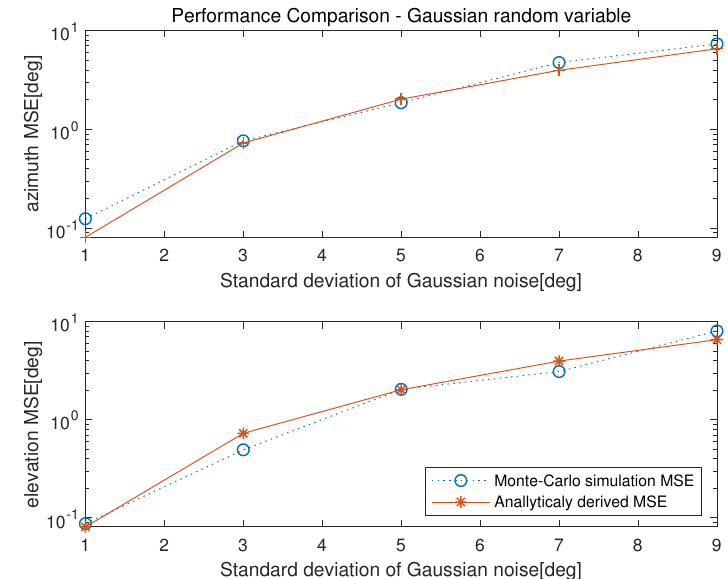
Figure 3. Performance for Gaussian − distributed phase measurement error with θ ( 0 ) = 120 ◦ and ψ ( 0 ) = 45 ◦ . This figure shows the MSEs of azimuth and elevation with respect to phase error at a signal with medium incident elevation. It can be confirmed that the MSE of elevation is similar to that of the azimuth at medium elevation(uniform circular